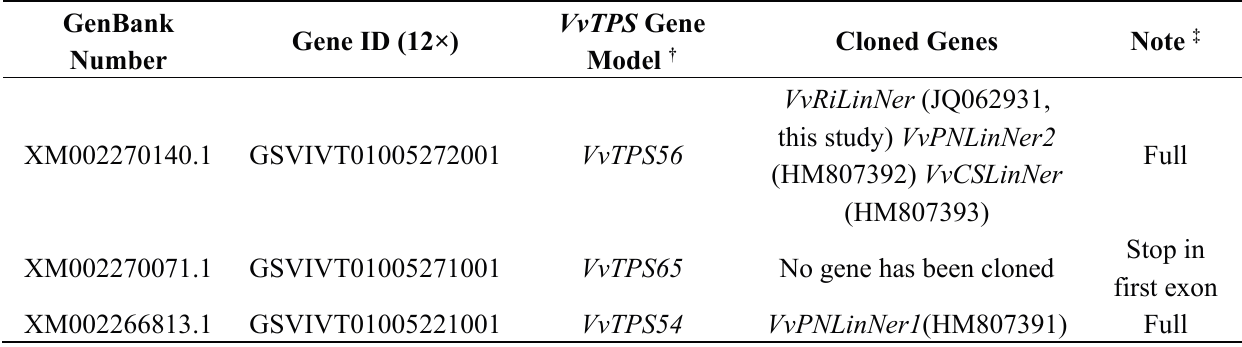
Table 1. Annotation of the three terpenoids synthase ( VvTPS )